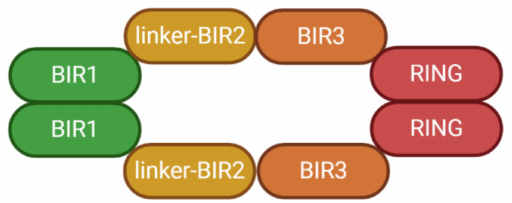
Figure 1. The structure of X-linked inhibitor of apoptosis protein (XIAP) homodimer. BIR: baculoviral IAP repeat. RING: RING (Really Interesting New Gene) finger